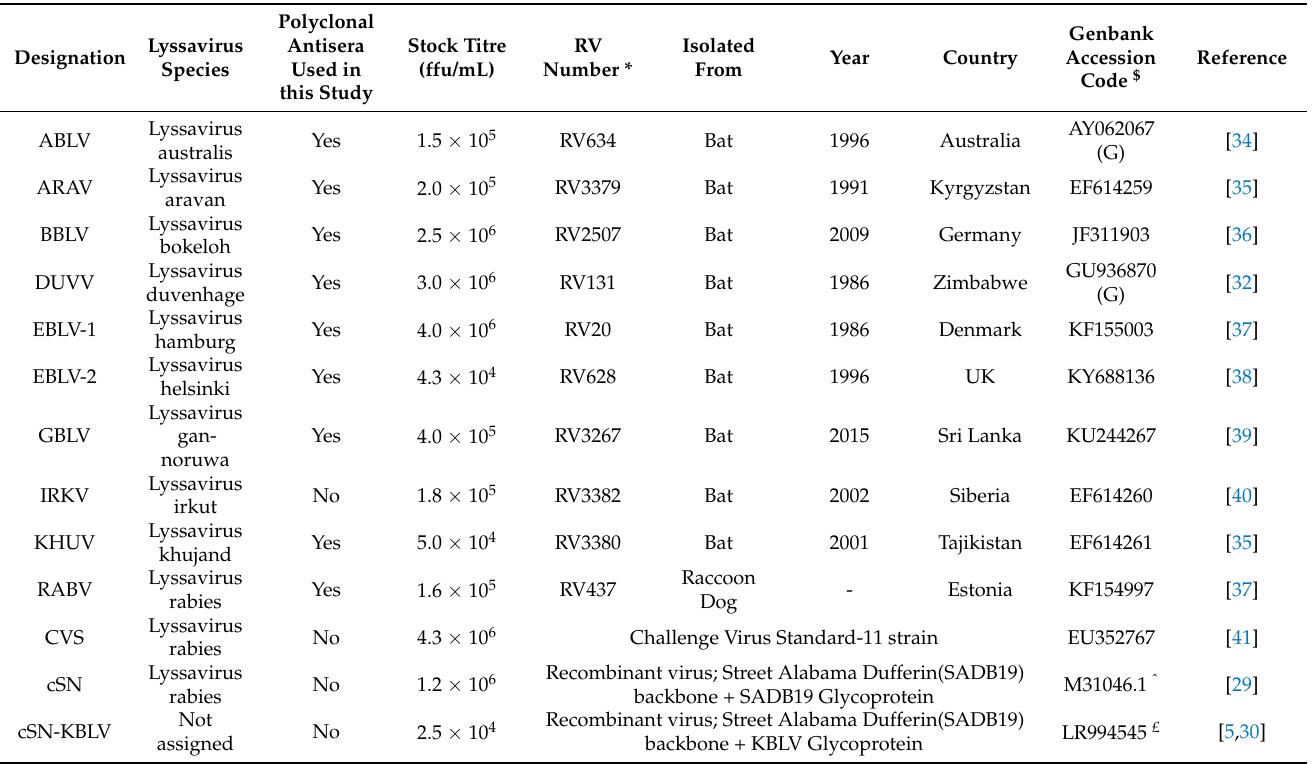
Table 1. Virus panel used and stock